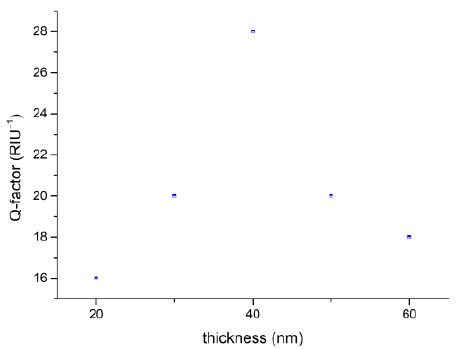
Figure 6. Q-factor in dependence of TiO 2 thickness.